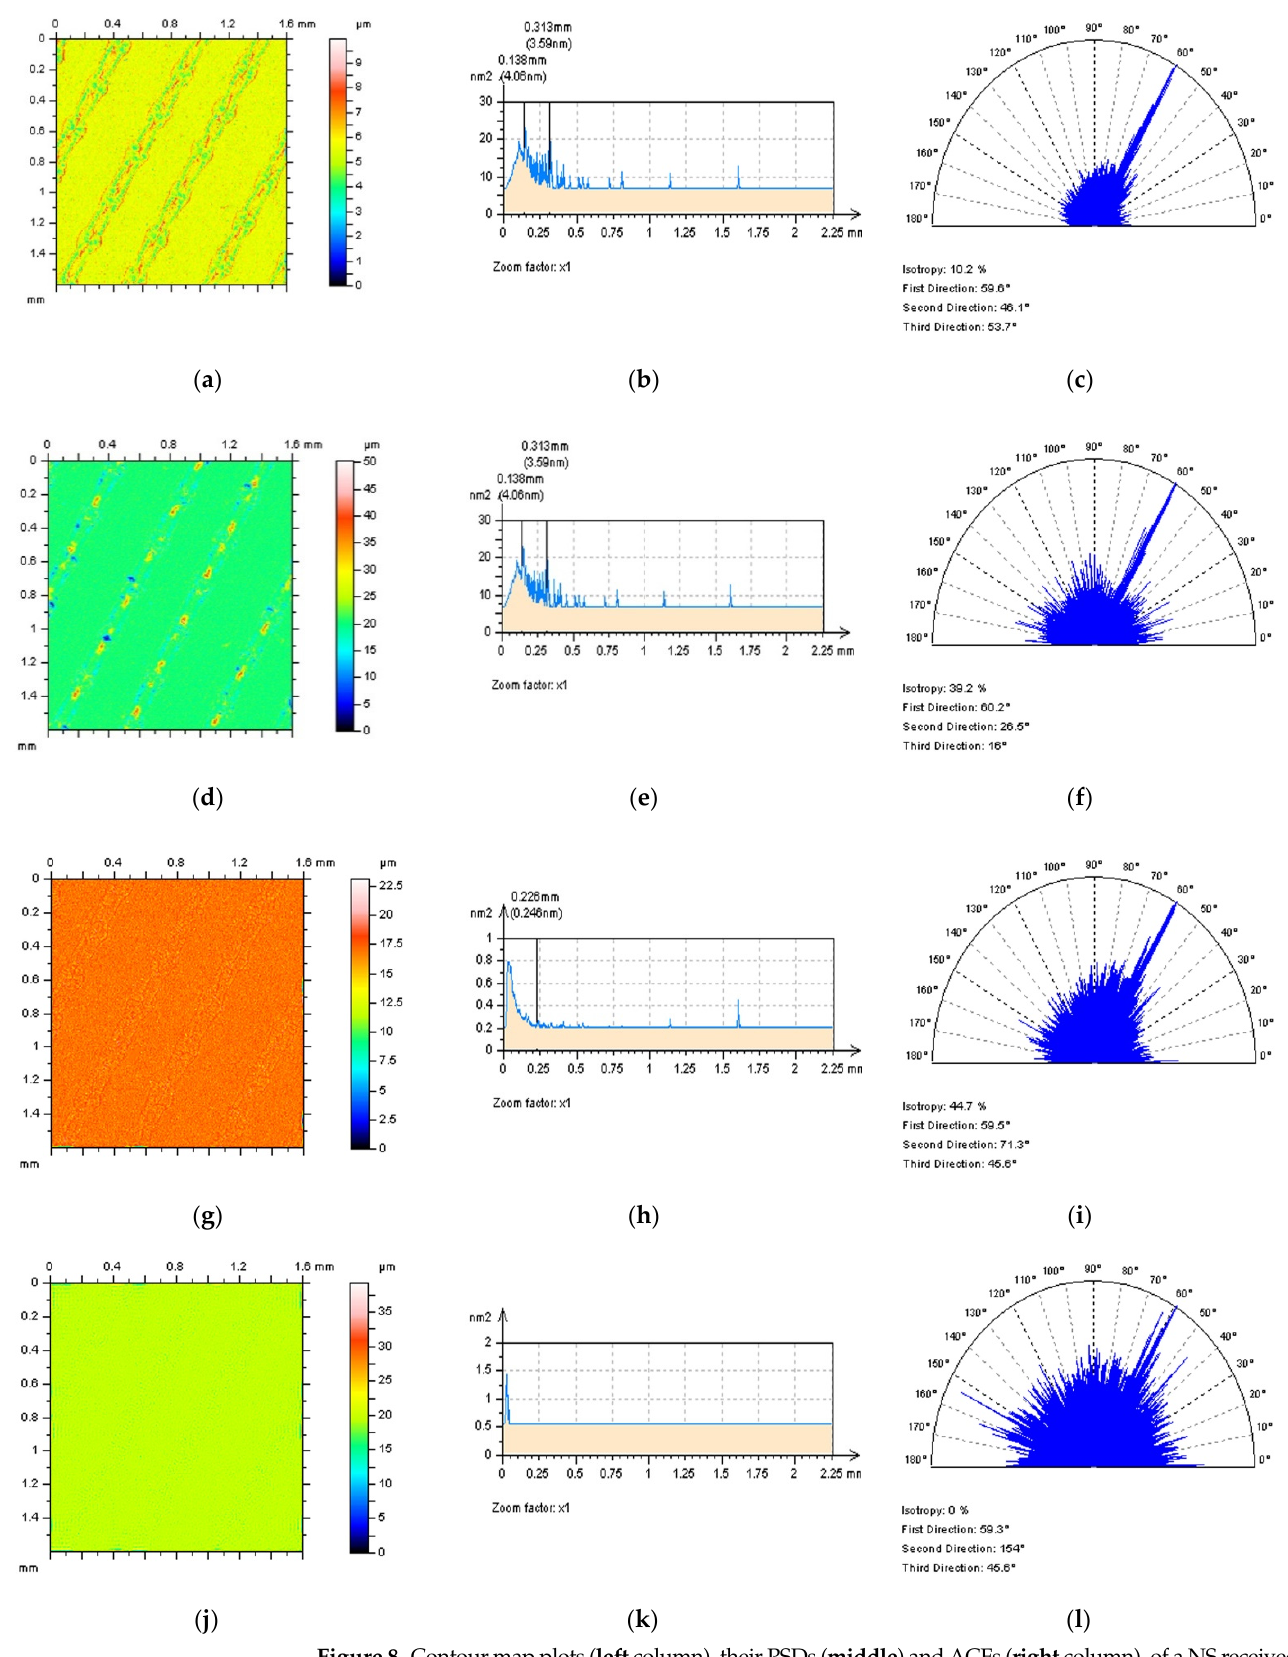
Figure 8. Contour map plots ( left column), their PSDs ( middle ) and ACFs ( right column), of a NS received by application of GF ( a – c ), RGF ( d – f ), SF ( g – i ) and FFTF ( j – l ) method with the cutoff = 0.025